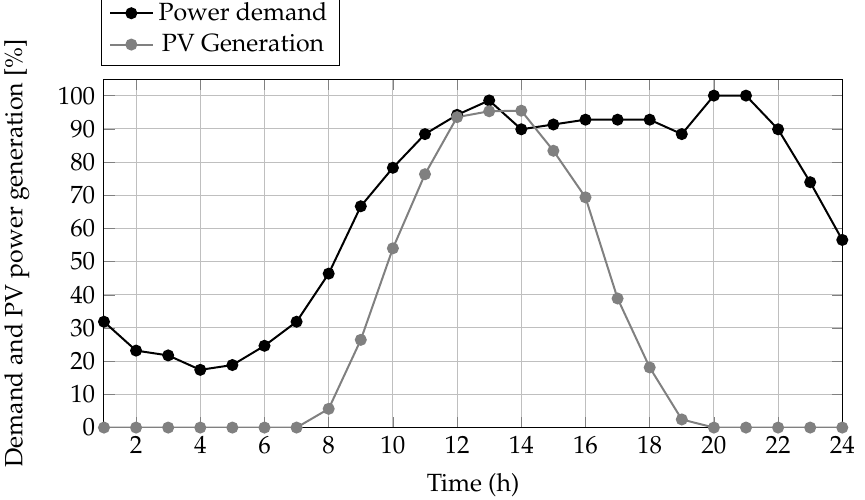
Figure 3. Typical power demand and PV generation behavior in Antioquia, Colombia